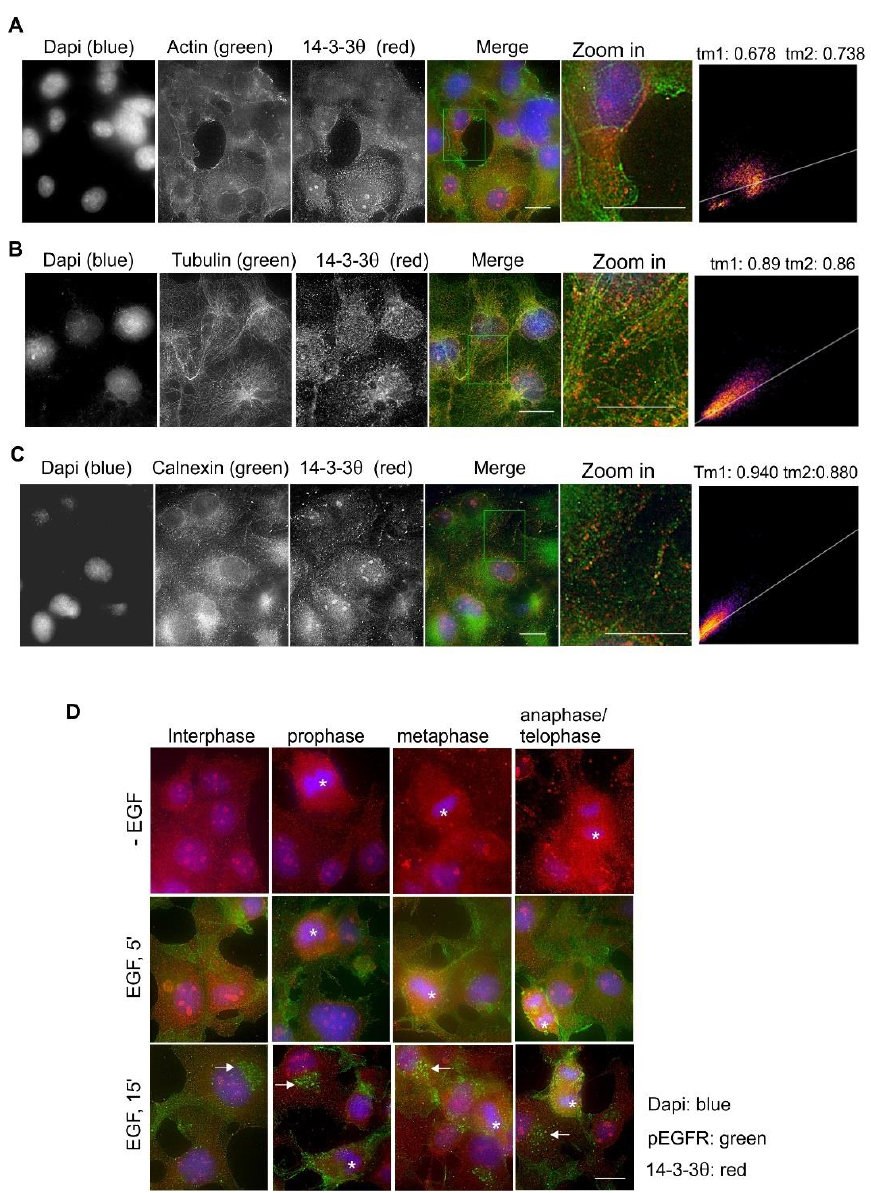
Figure 9. Subcellular localization of 14-3-3 θ in Cos-7 cells by double indirect immunofluorescence. ( A ) Co-localization of 14-3-3 θ (red) and actin (green); ( B ) co-localization of 14-3-3 θ (red) and tubulin (green); ( C ) co-localization of 14-3-3 θ (red) and calnexin (green). For ( A – C ), the zoomed-in areas were used to calculate Mander’s coefficients. ( D ) Subcellular localization of 14-3-3 θ during the cell cycle and in response to EGF. With or without EGF stimulation, 14-3-3 θ (red) and pEGFR (green) were revealed by double indirect immunofluorescence. Mitotic cells are labeled by * and endosomes are marked by arrows. Scale bar = 10 μm.